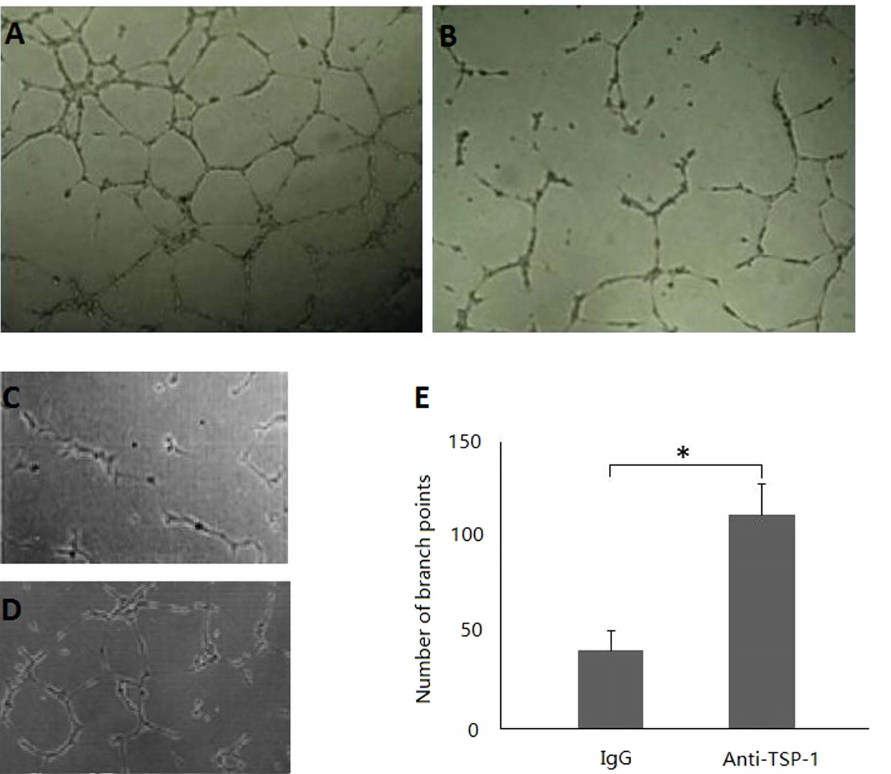
Figure 4. Effect of platelet-released cytokines on angiogenic activity of HUVEC. Representative photographs of the tube formation assay after 18 h of co-incubation with platelet-released cytokines are shown in panels A (the patients platelet-released cytokines added) and B (healthy controls platelet-released cytokines added). Preincubation of platelet lysates with IgG control (C) and antiTSP-1 antibody (D). The statistical analysis (E). Bars are means 6 SD from 4 experiments. * P , 0.05 control versus